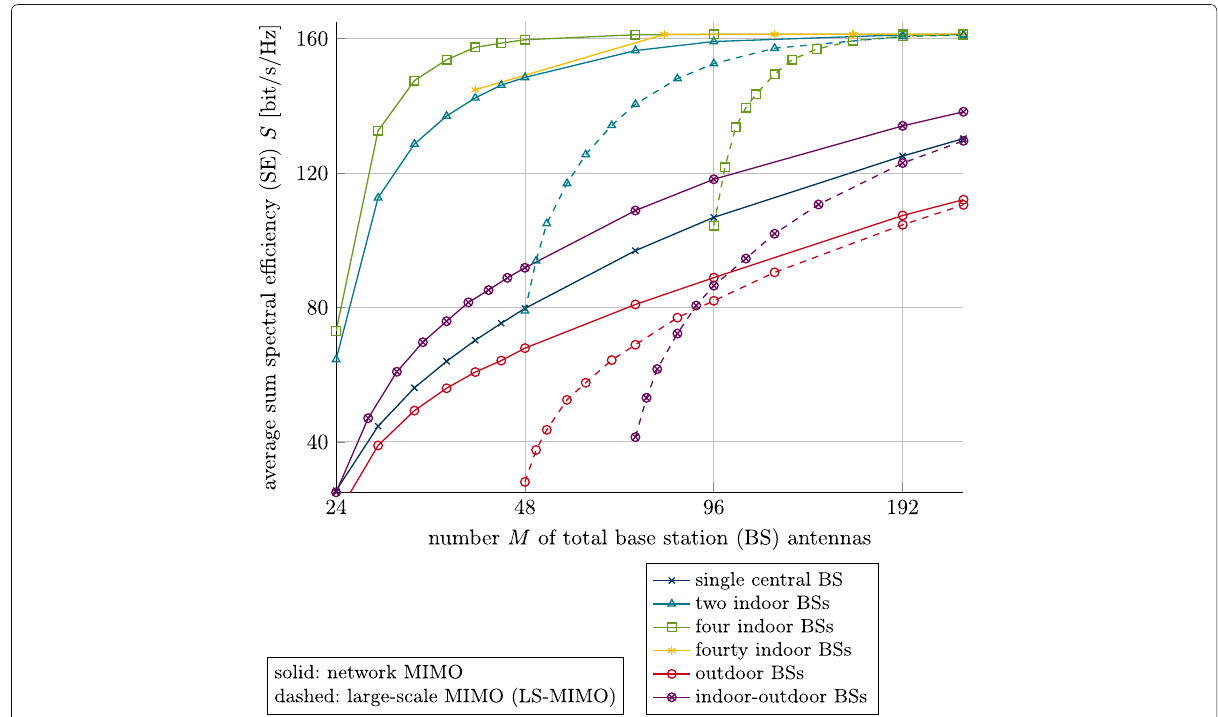
Fig. 2 Network MIMO versus LS-MIMO. Average sum SEs with network MIMO and LS-MIMO for 256 QAM and mercury/water-filling